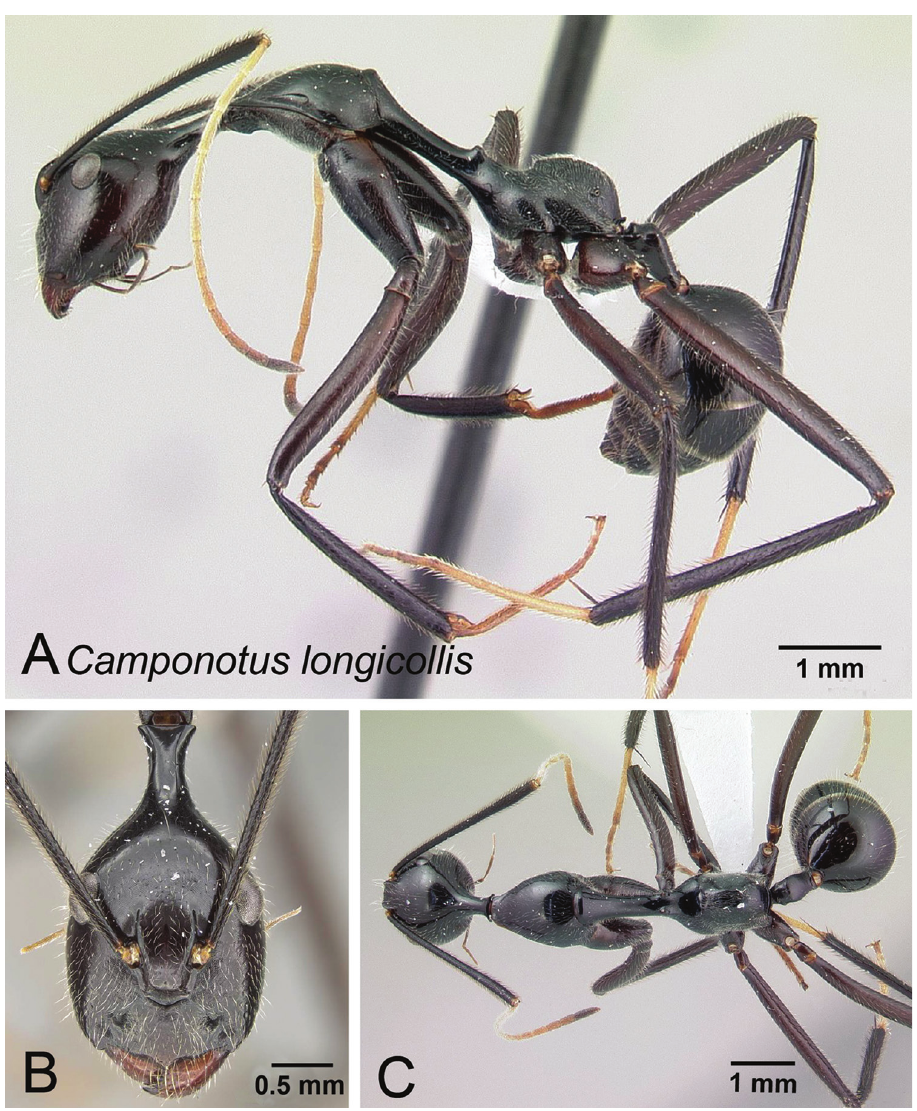
Figure 16. Camponotus longicollis minor worker CASENT0191989. A Lateral view B Head in full-face view C Dorsal